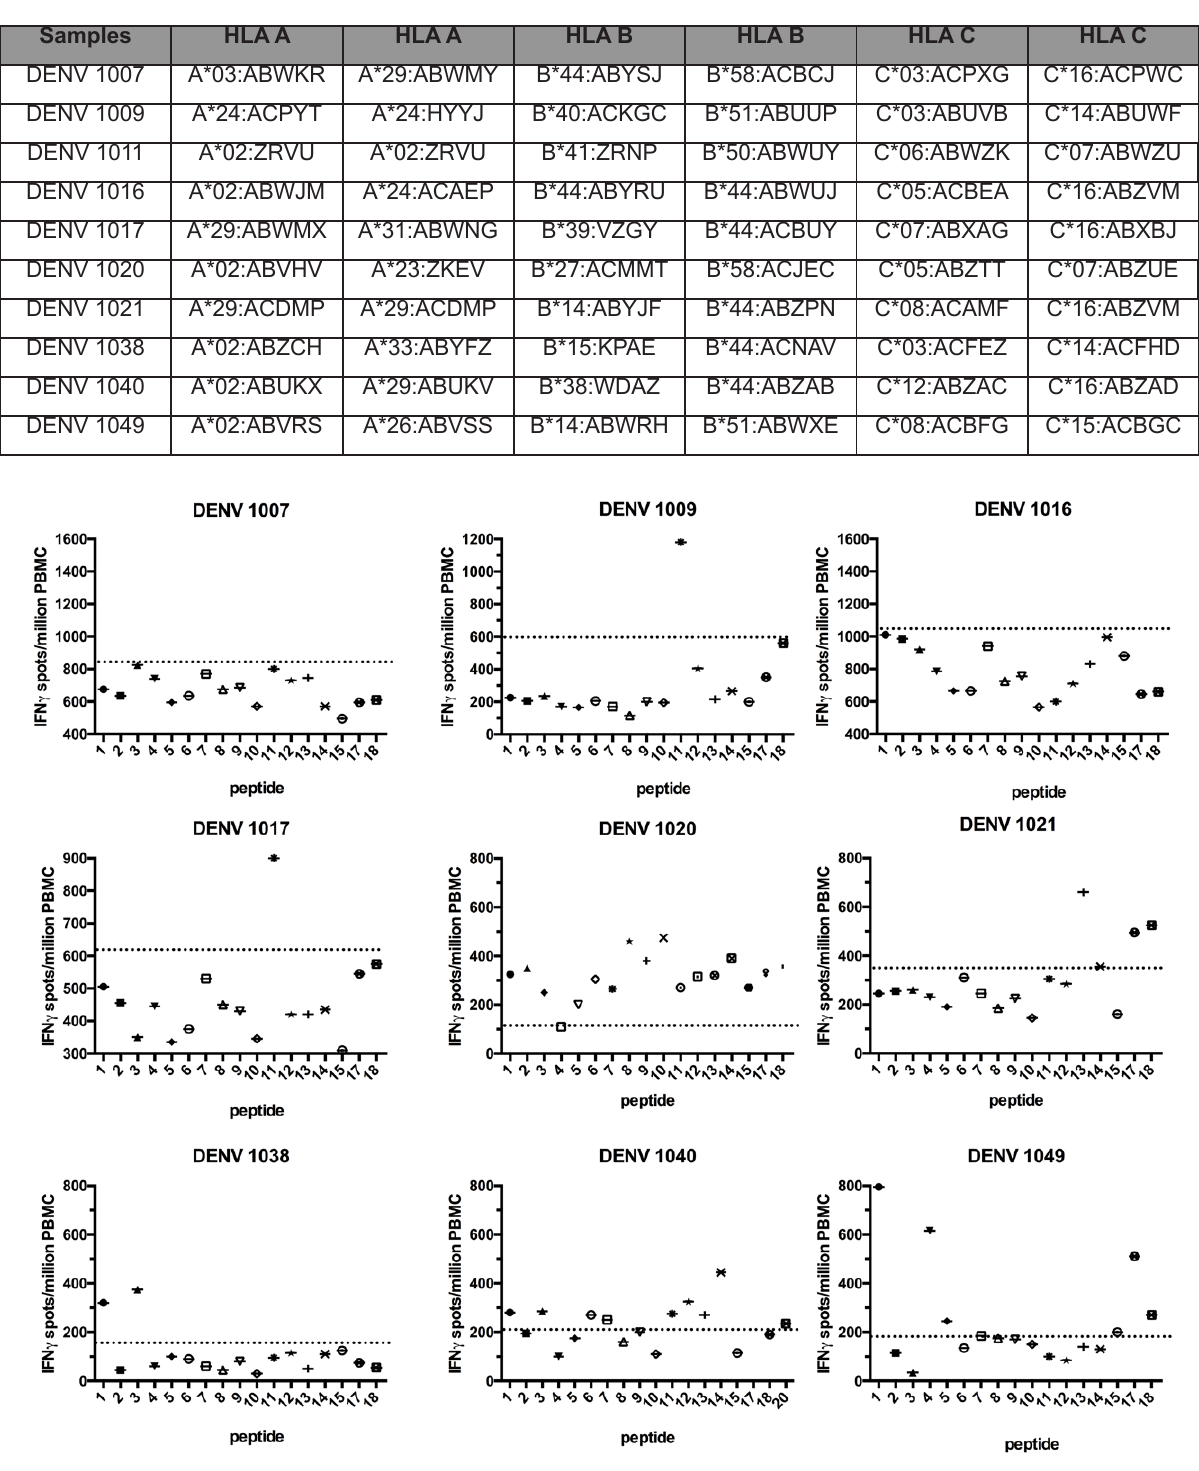
Table 4: HLA-I alleles of DENV-vaccinated participants. Samples